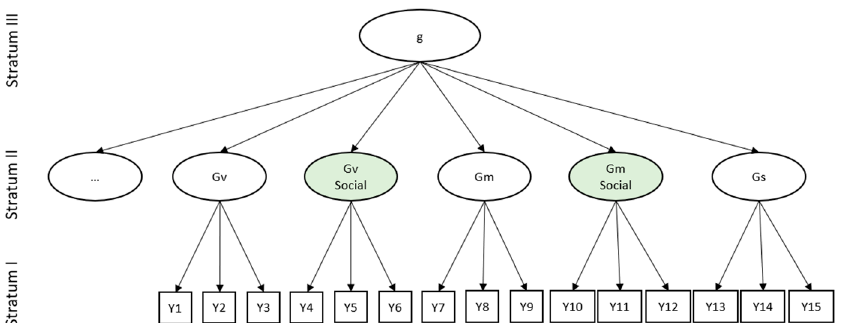
Figure 4. Integration of face memory and perception abilities into the Three-Stratum Model of intelligence (e.g., McGrew 2009). g —general factor of cognitive abilities; Gv—general factor of visual processing, i.e., perception; Gv Social— suggested specific factor of perceiving social stimuli in difficult tasks, in our case faces; Gm—general factor of memory; Gm social—suggested specific factor of memorizing faces in difficult tasks; Gs—general mental speed factor. Y1 to Y15— task-derived indicators. Green shades indicate new social factors suggested here.